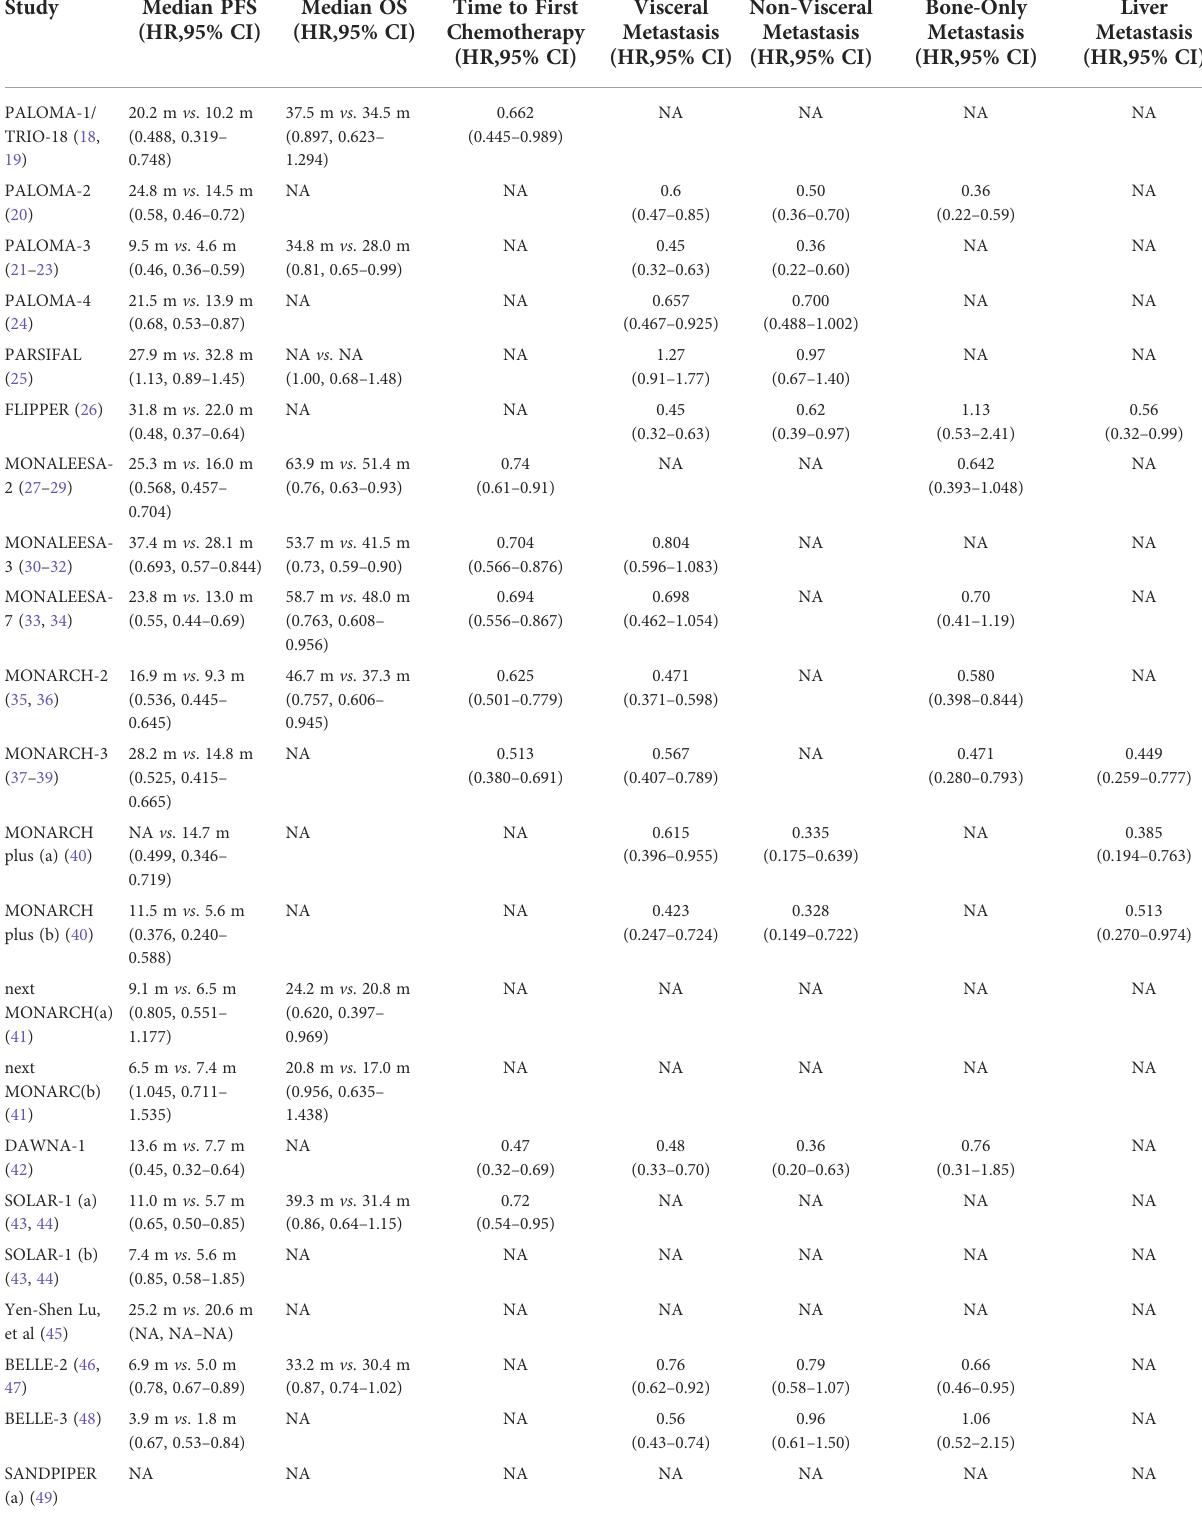
TABLE 2 Survival outcomes of